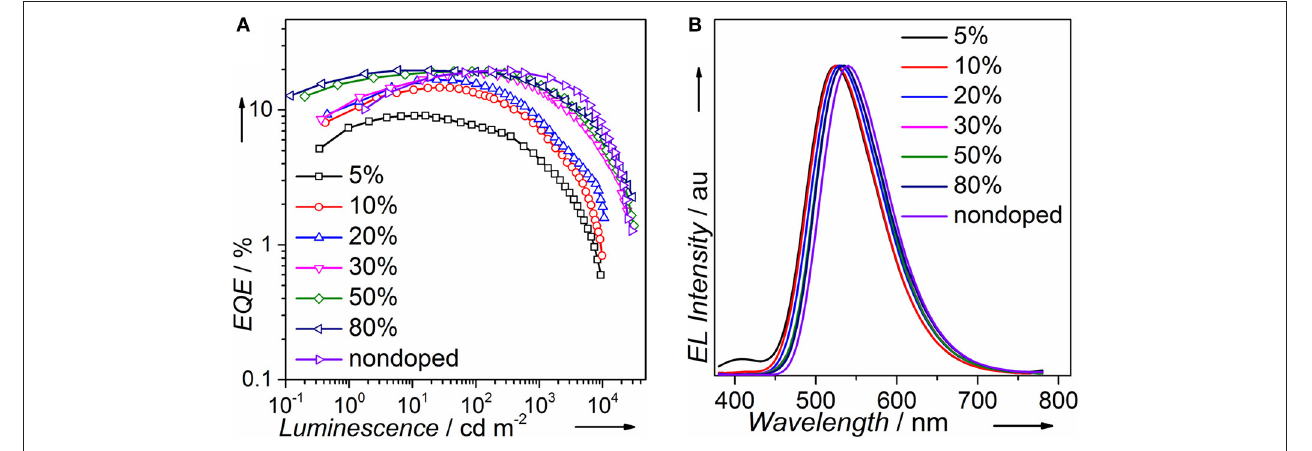
FIGURE 5 | (A) EQE and (B) EL spectra at 7V of PTZMes 2 B